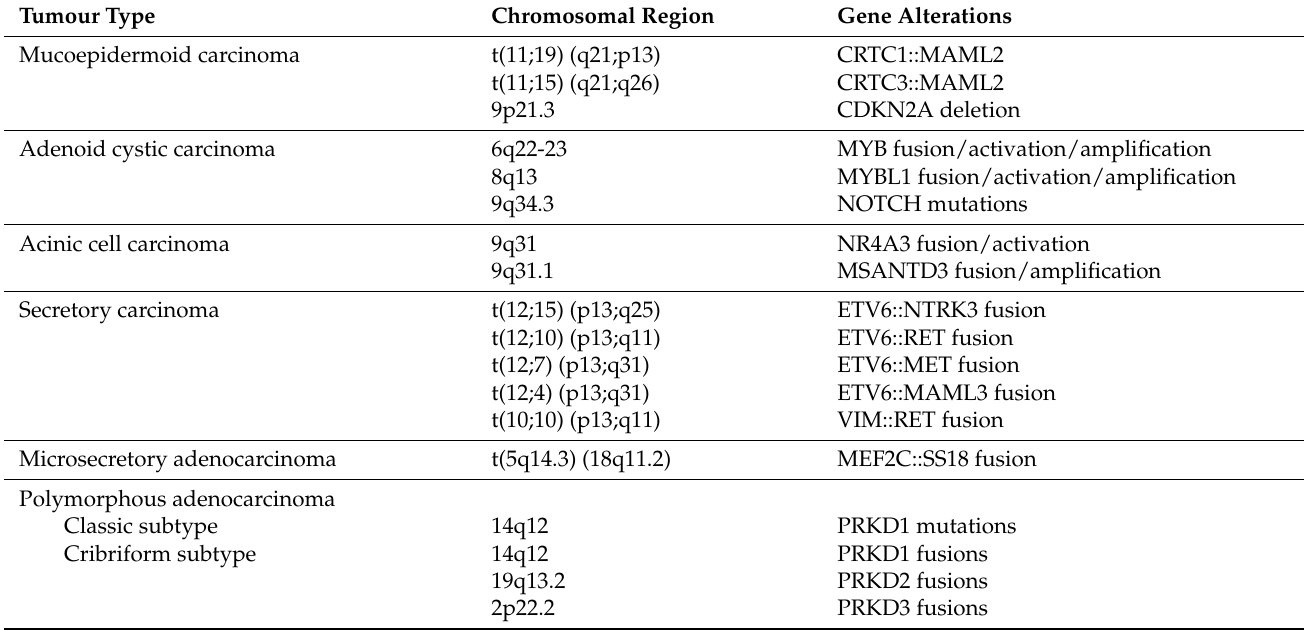
Table 4. Comparison of histological diagnoses and gene